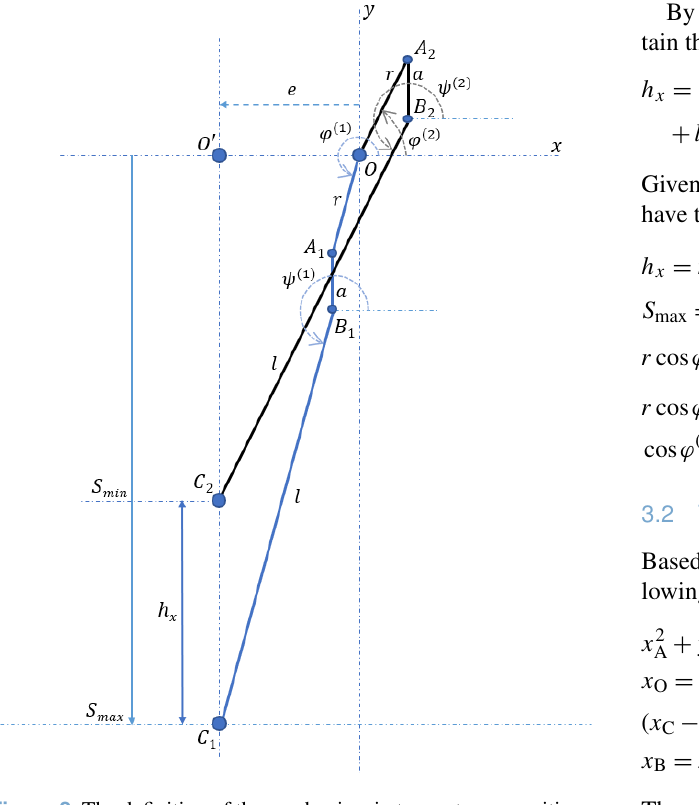
Figure 2. The definition of the mechanism in two extreme positions of the